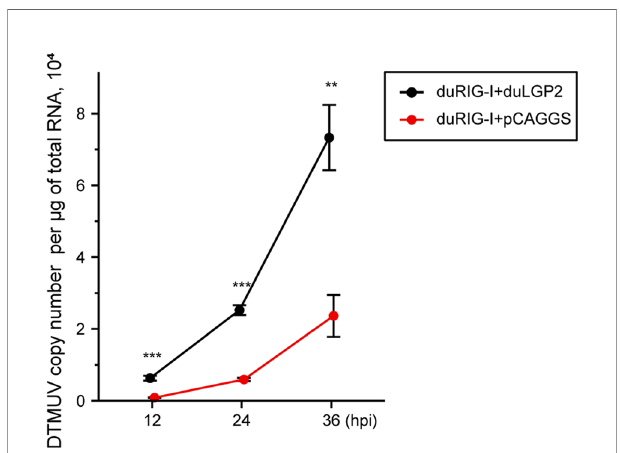
FIGURE 5 | duLGP2 inhibits duRIG-I-mediated anti-DTMUV activity. Cells were transiently co-transfected with indicated expression plasmids or empty plasmids pCAGGS. Cells were infected with DTMUV at 24 hpt and collected for analysis of virus replication at different time points. All samples were analyzed in triplicate, and all data were expressed as means ± SEM. **Highly signi fi cant difference ( P < 0.01); ***Extremely signi fi cant ( P < 0.001).